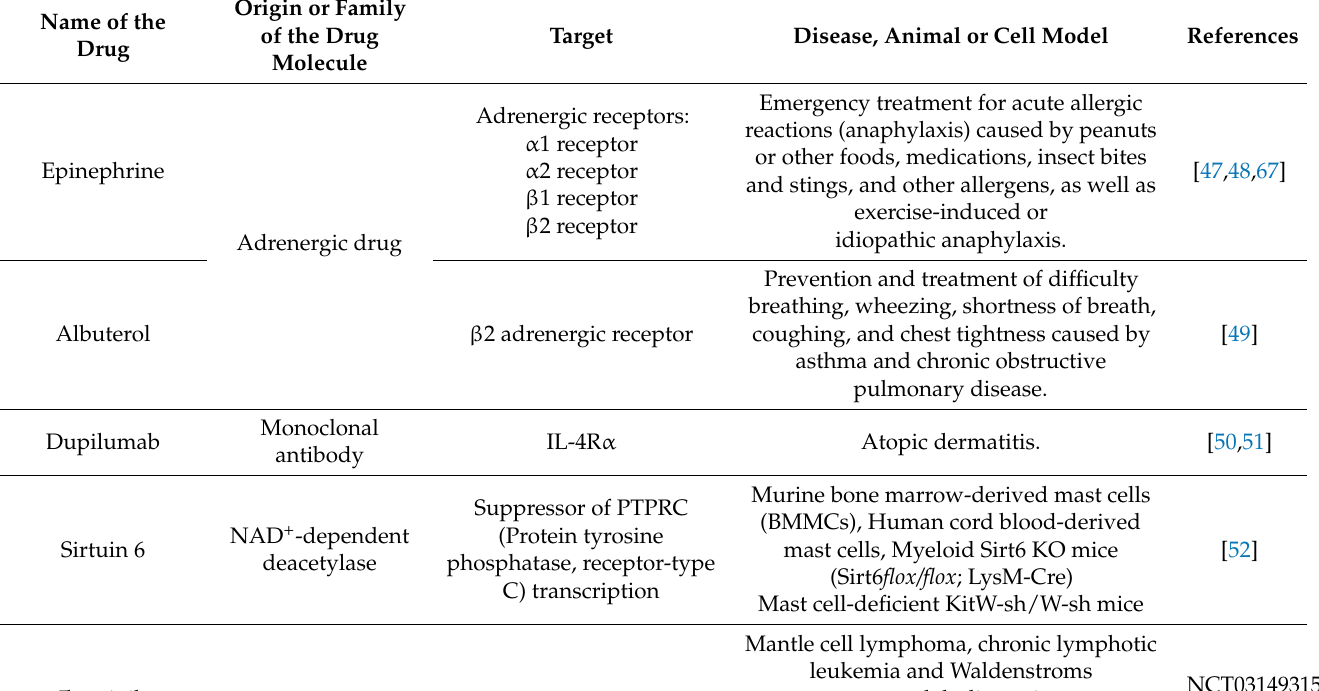
Table 2. Drugs for anaphylactic shock